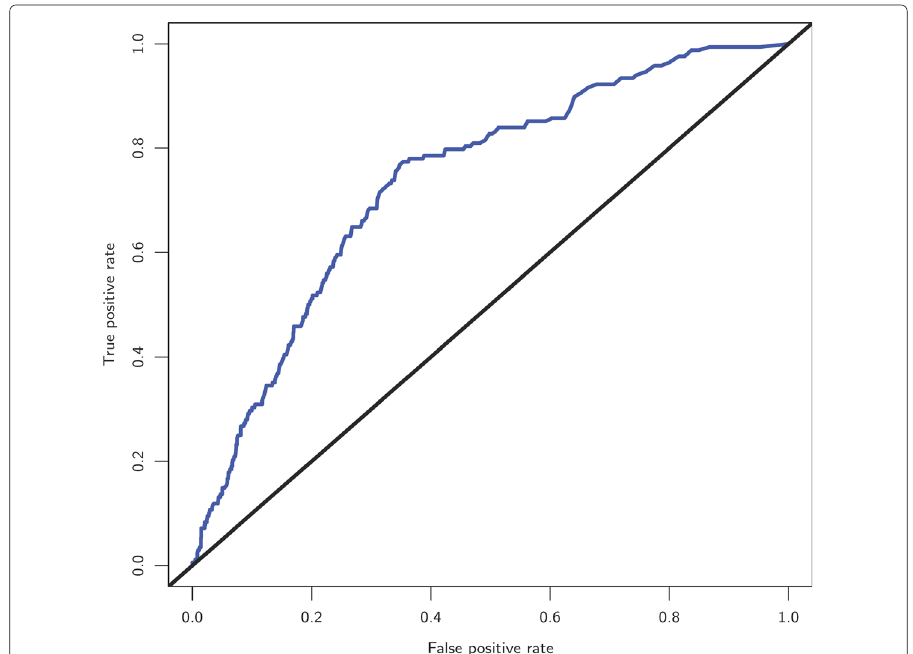
Fig. 5 Prediction performance of high consumption enterprises as ROC curve